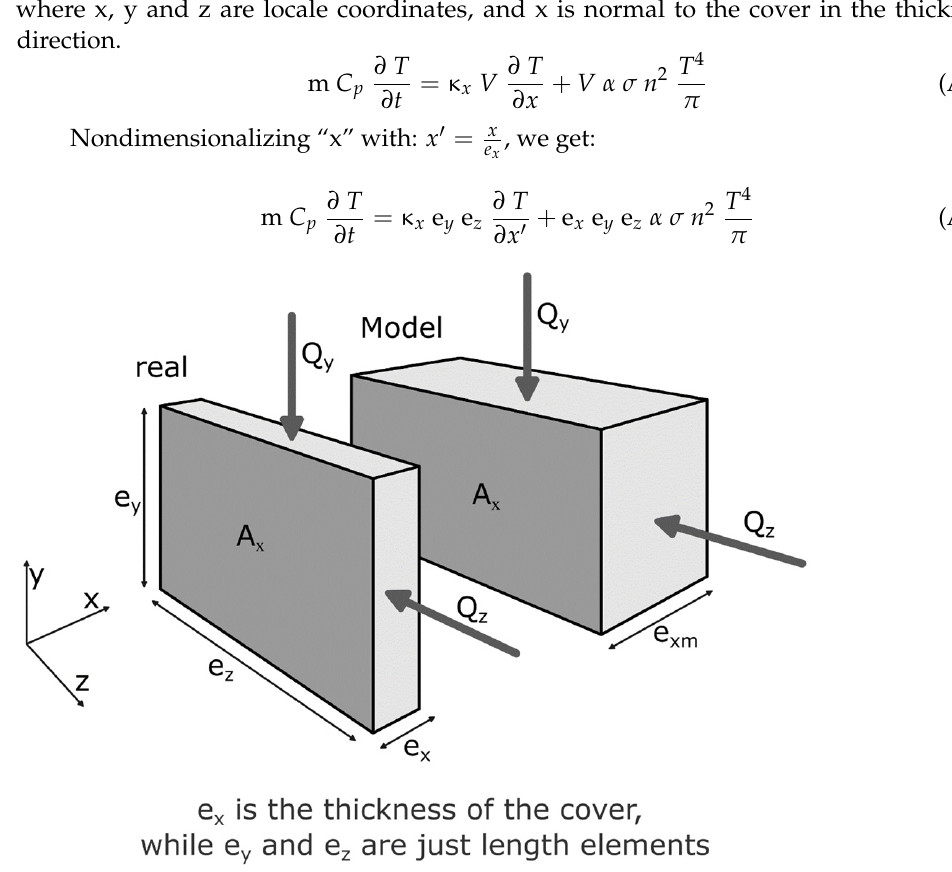
Figure A1. A volume element of the real cover and the model cover where only the thickness 𝐞 𝒙 varies.